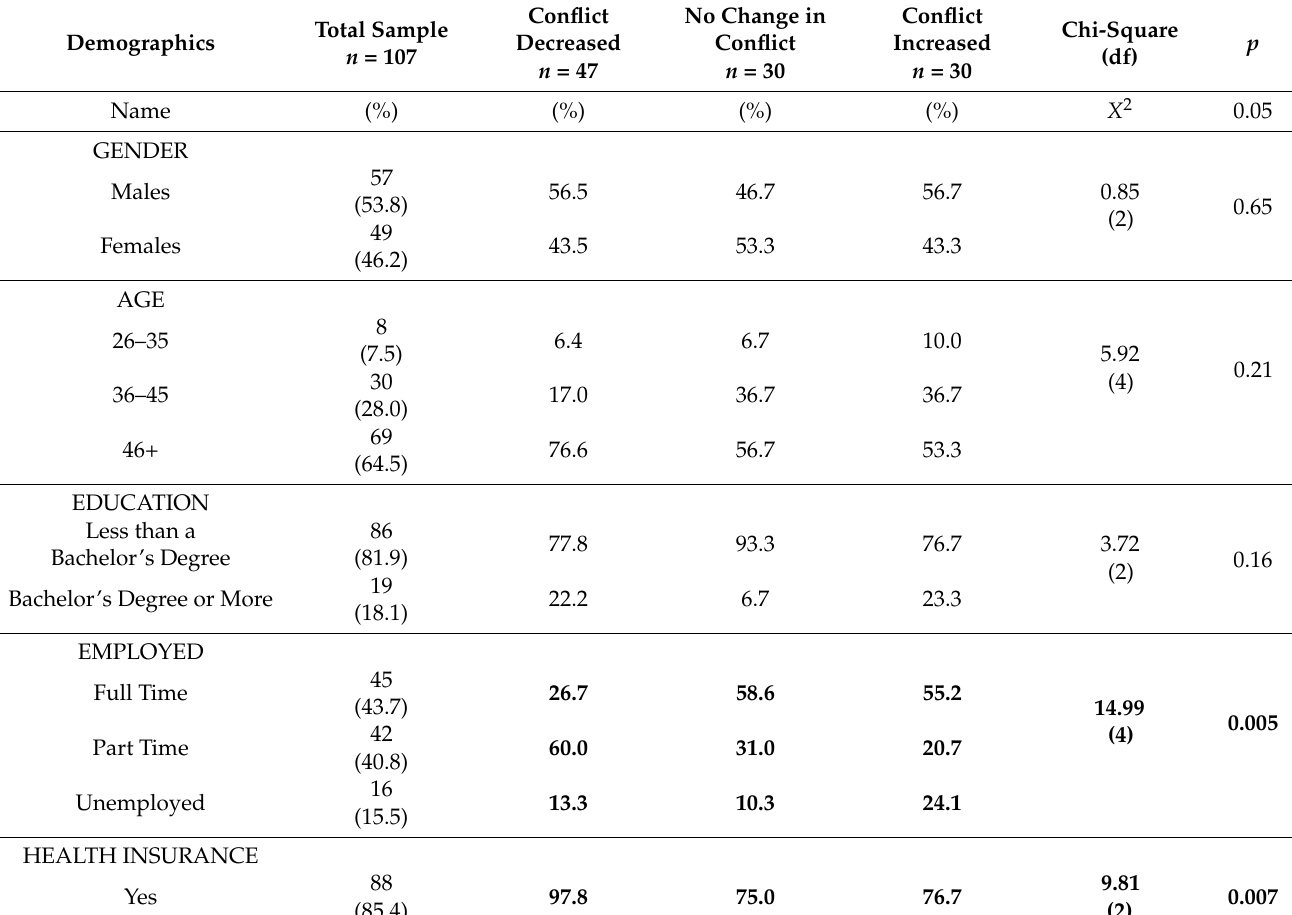
Table 1. Chi-square analyses of the three couple–conflict groups and participants’